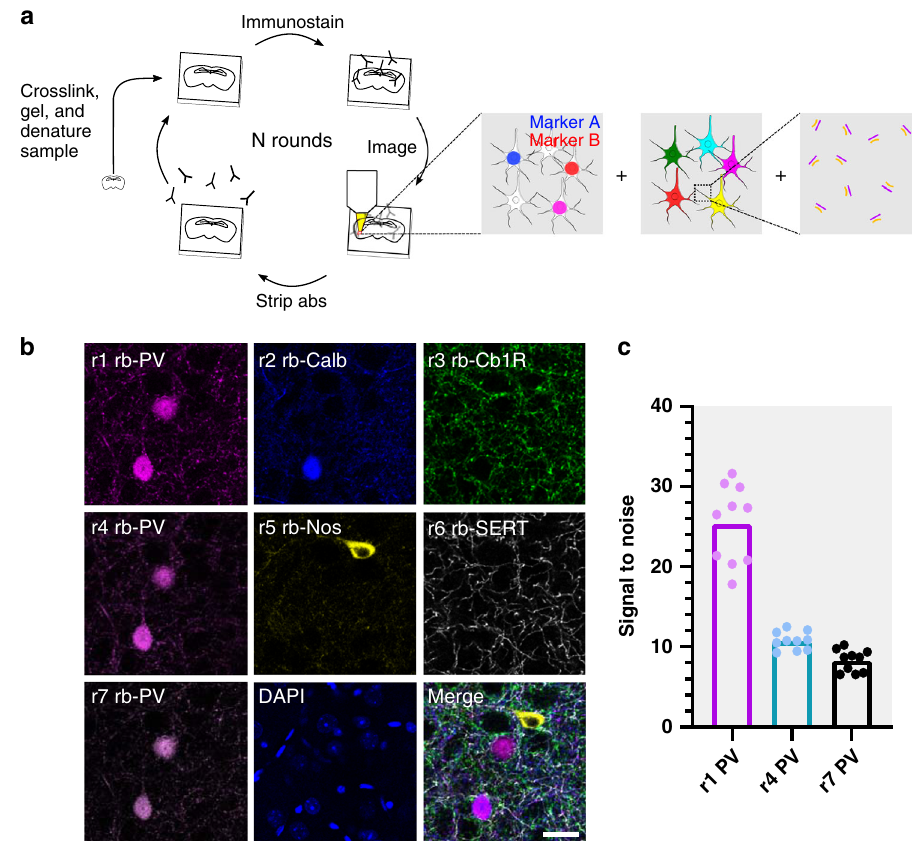
Fig. 1 miriEx robustly preserves antigens across multiple rounds of immunostaining, imaging, and stripping. a miriEx strategy to simultaneously measure molecular pro fi le, morphology, and/or connectivity. Tissue samples are embedded in a hydrogel to create expandable gel-tissue hybrids. The sample can then undergo multiple rounds of immunostaining, imaging, and stripping to measure various neuron properties. We then register and merge the different rounds of imaging to correlate the results. b Five distinct rabbit antibodies were used across 7 sequential rounds of immunostaining, with PV re- probed in rounds 4 and 7 to demonstrate retention of antigen. The merged image shows r1 PV, r2 Calb, r3 Cb1R, r5 NOS, and r6 SERT. c Signal to noise was quanti fi ed for PV immunostaining in round 1, round 4, and round 7 ( n = 10 neurons). Abs antibodies, PV parvalbumin, Calb calbindin, Cb1R cannabinoid receptor type 1, Nos nitric oxide synthase, SERT serotonin transporter. Scale bar: ( b ) 25 μ m (pre-expansion size). Expansion factor: ( b ) ~2×. See Supplementary Table 1 for more